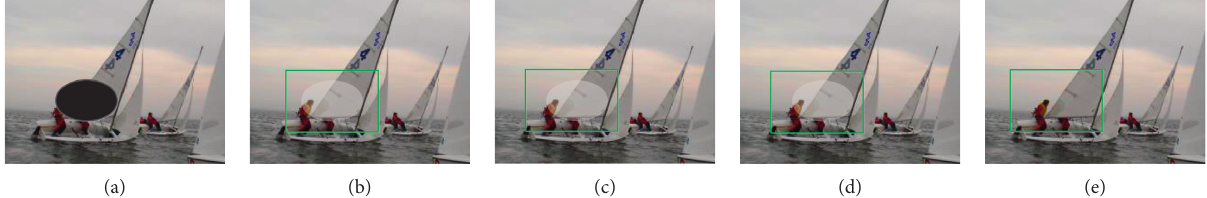
Figure 7: Comparison of the effect of portrait removal color image restoration. (a) Original image, (b) Criminisi algorithm result, (c) adaptive repair algorithm result, (d) sparsity repair algorithm result, and (e) algorithm result of this